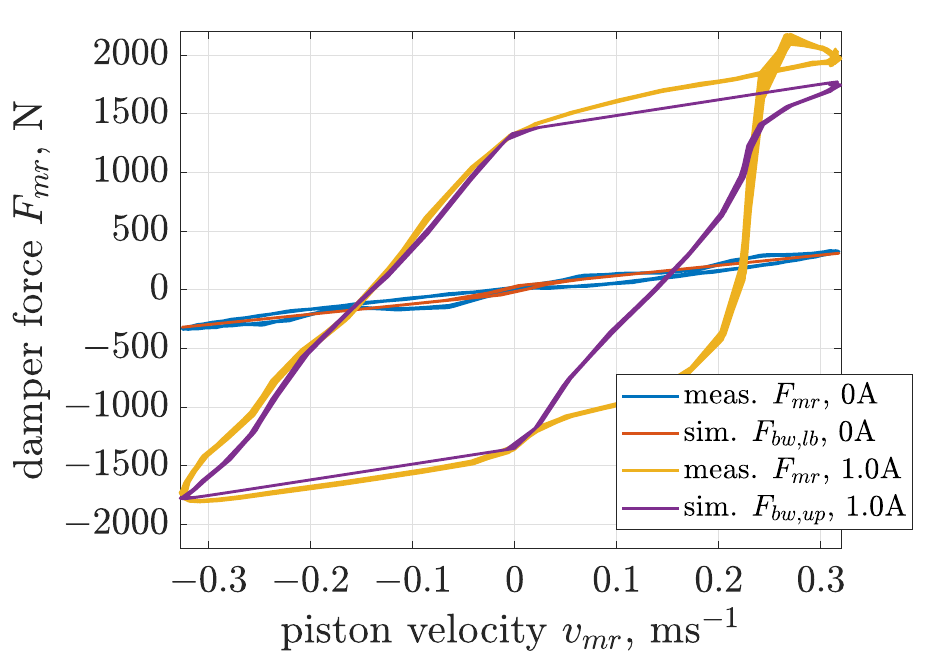
Figure 16. Comparison of force–velocity characteristics obtained for the MR damper and the Bouc–Wen model subjected to the sinusoidal excitation of frequency 20 Hz and displacement amplitude 2